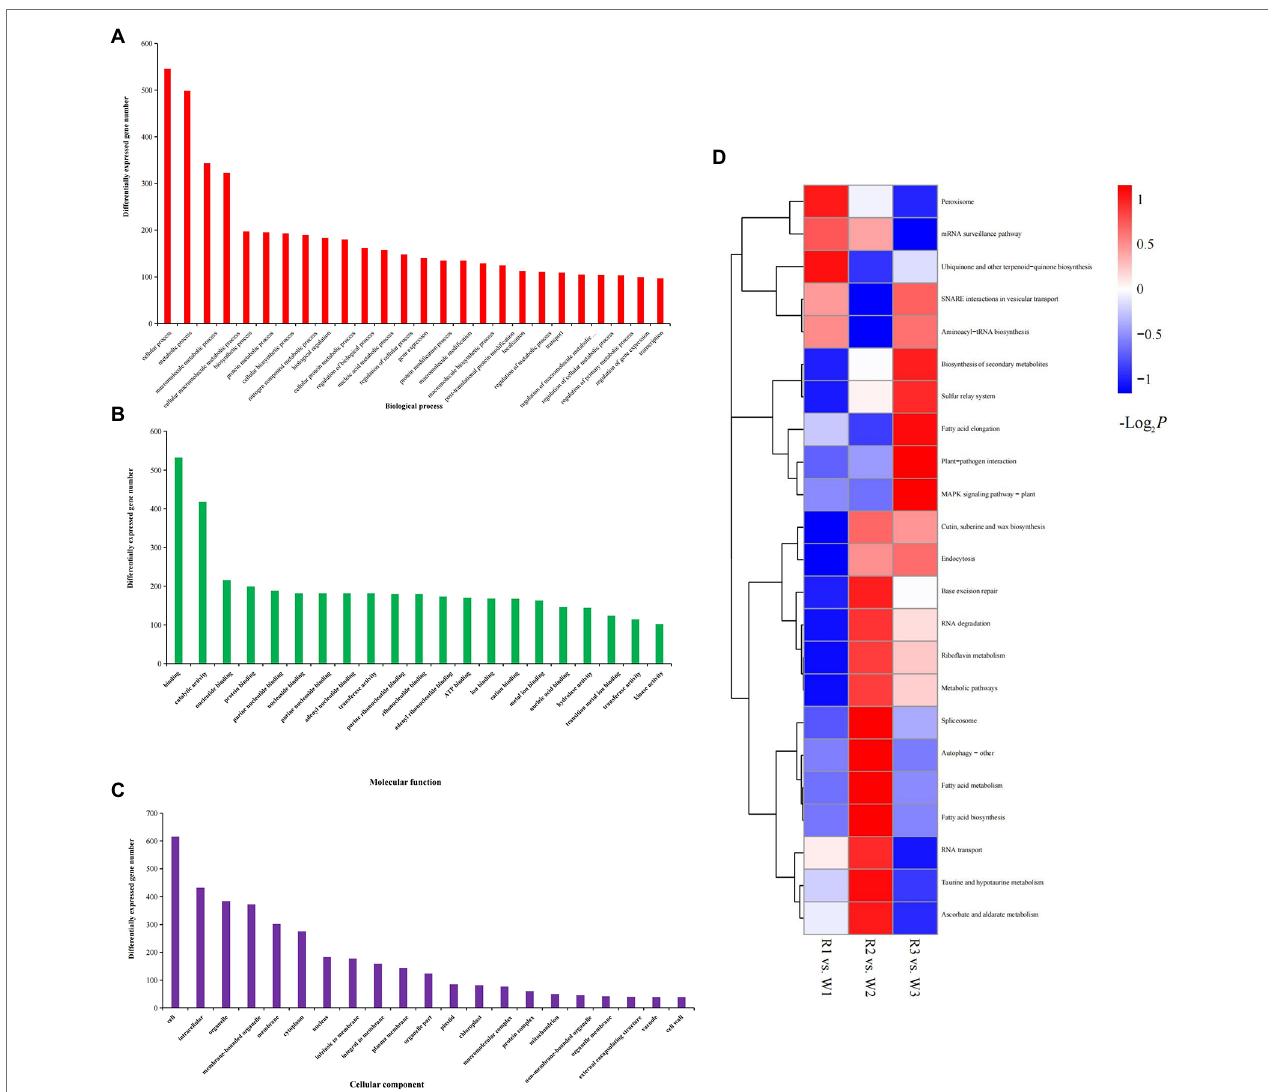
FIGURE 4 | Gene Ontology analysis and Kyoto Encyclopedia of Genes and Genomes (KEGG) enrichment of differentially expressed genes (DEGs) identified by comparison of white (W) and red (R) flowers at early (W1, R1), middle (W2, R2), and blooming (W3, R3) stages. (A) DEGs enriched in biological process; (B) DEGs enriched in cellular components; and (C) DEGs enriched in molecular functions; and (D) KEGG enrichment analysis of